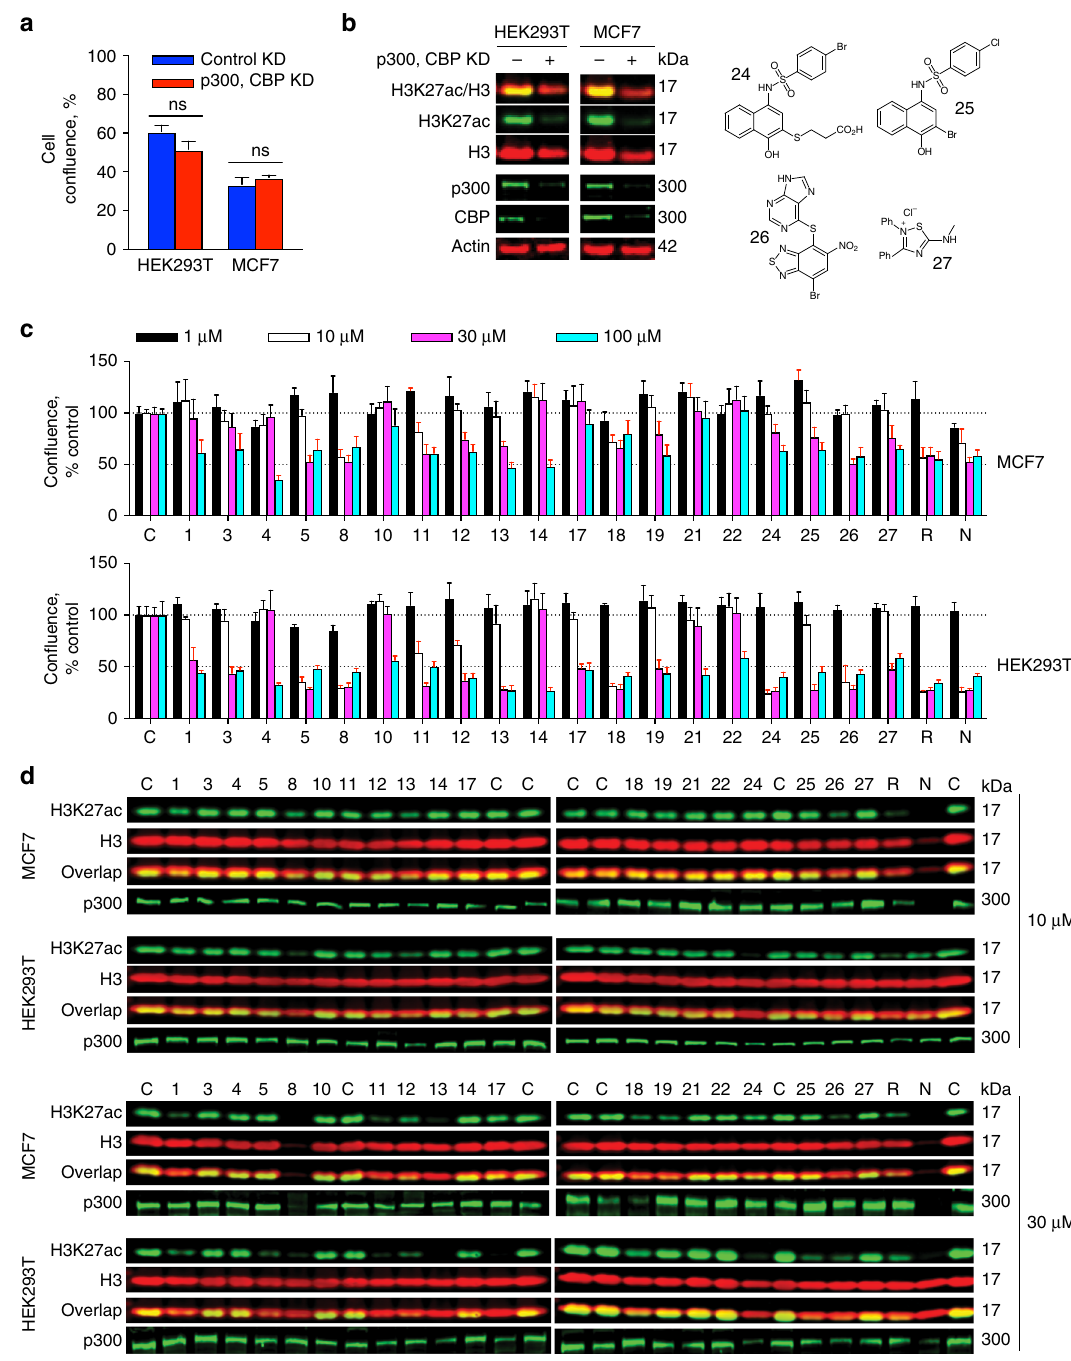
Fig. 4 Reported HAT inhibitors cause nonspeci fi c cell assay readouts. a Double p300 and CBP knockdowns do not affect cell viability after 2 d. Data are expressed as mean ± SEM of three technical replicates (ns, not signi fi cant; two-tailed Student ’ s t -test). b Double p300 and CBP knockdowns ef fi ciently reduce H3K27ac levels in HEK293T and MCF7 cells. Molecular weight of probed protein is indicated in kilodaltons (kDa) as veri fi ed by molecular weight markers. Data are representative results from one of two independent experiments. c Many reported HAT inhibitors exert anti-proliferative effects at low micromolar compound concentrations in (top) MCF7 and (bottom) HEK293T cells as monitored by cell con fl uence 24 h after addition of compound. Note the nonspeci fi c interference compounds NSC-663284 (N), rottlerin (R), and 24 – 27 (chemical structures shown as inset) demonstrate similar anti- proliferative effects. C, DMSO control. Red error bars, statistically signi fi cant difference from respective DMSO controls ( p < 0.05; two-tailed Student ’ s t - test and Holm – Sidak method). Data are expressed as mean ± SD of three technical replicates and are representative results from one of two independent experiments. d Many reported HAT inhibitors also cause nonspeci fi c changes in H3K27ac and p300 levels in cells at low micromolar compound concentrations. Molecular weights of protein analytes are indicated in kDa as veri fi ed by molecular weight markers (Supplementary Fig. 9). Note the same known interference compounds from panel c can also decrease H3K27ac levels. Data are representative results from one of two independent